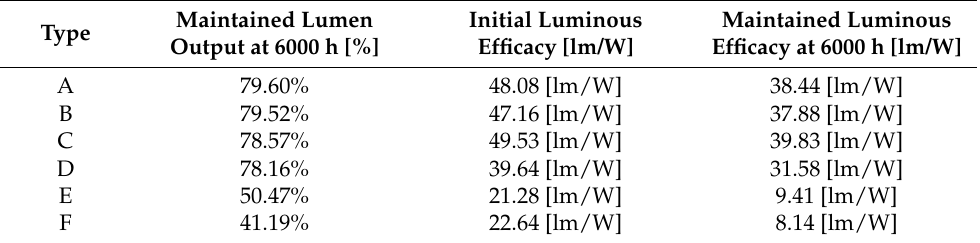
Table 3. Maintained lumen output and luminous efficacy of OLED panels and luminaires with operating of thousand